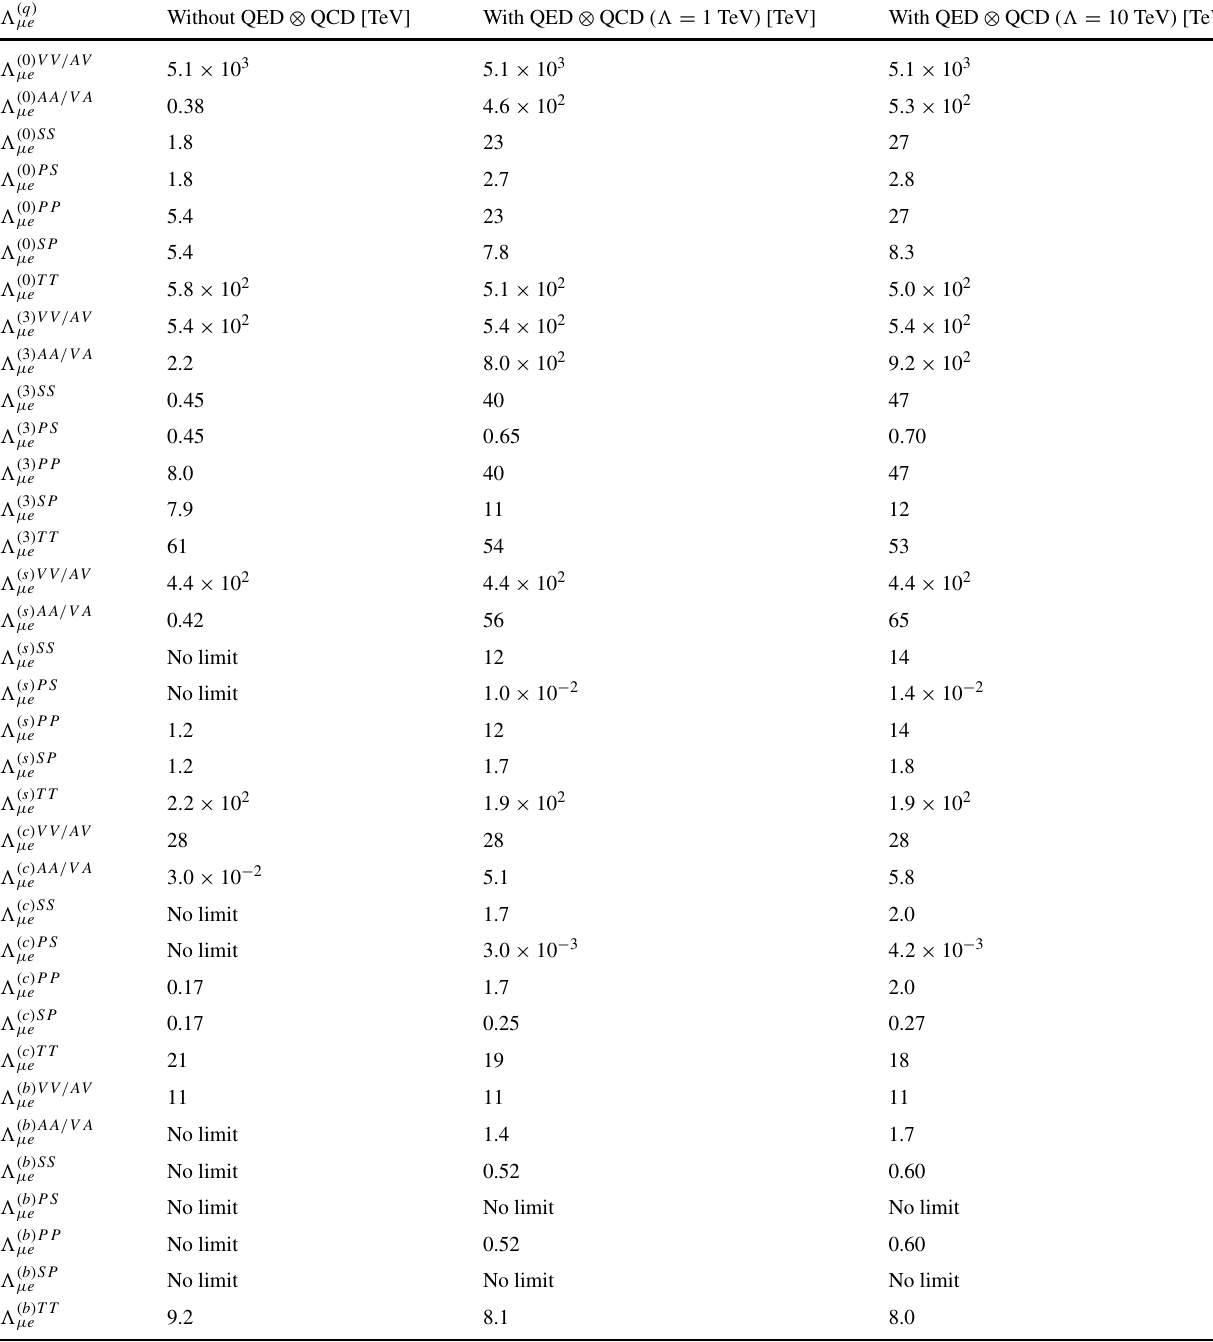
( q ) AB (cid:2) (cid:2) = 1 2 (cid:2) 1 (cid:2) 2 ( The improvement of the limits in the presence of QED ⊗ QCD correc- (cid:2) 1 (cid:2) 2 . For the defini- tions is due to operator mixing. The mixing among different operators (RGE evolution matrices) can be found in Appendix (cid:2) ∓ 1 2